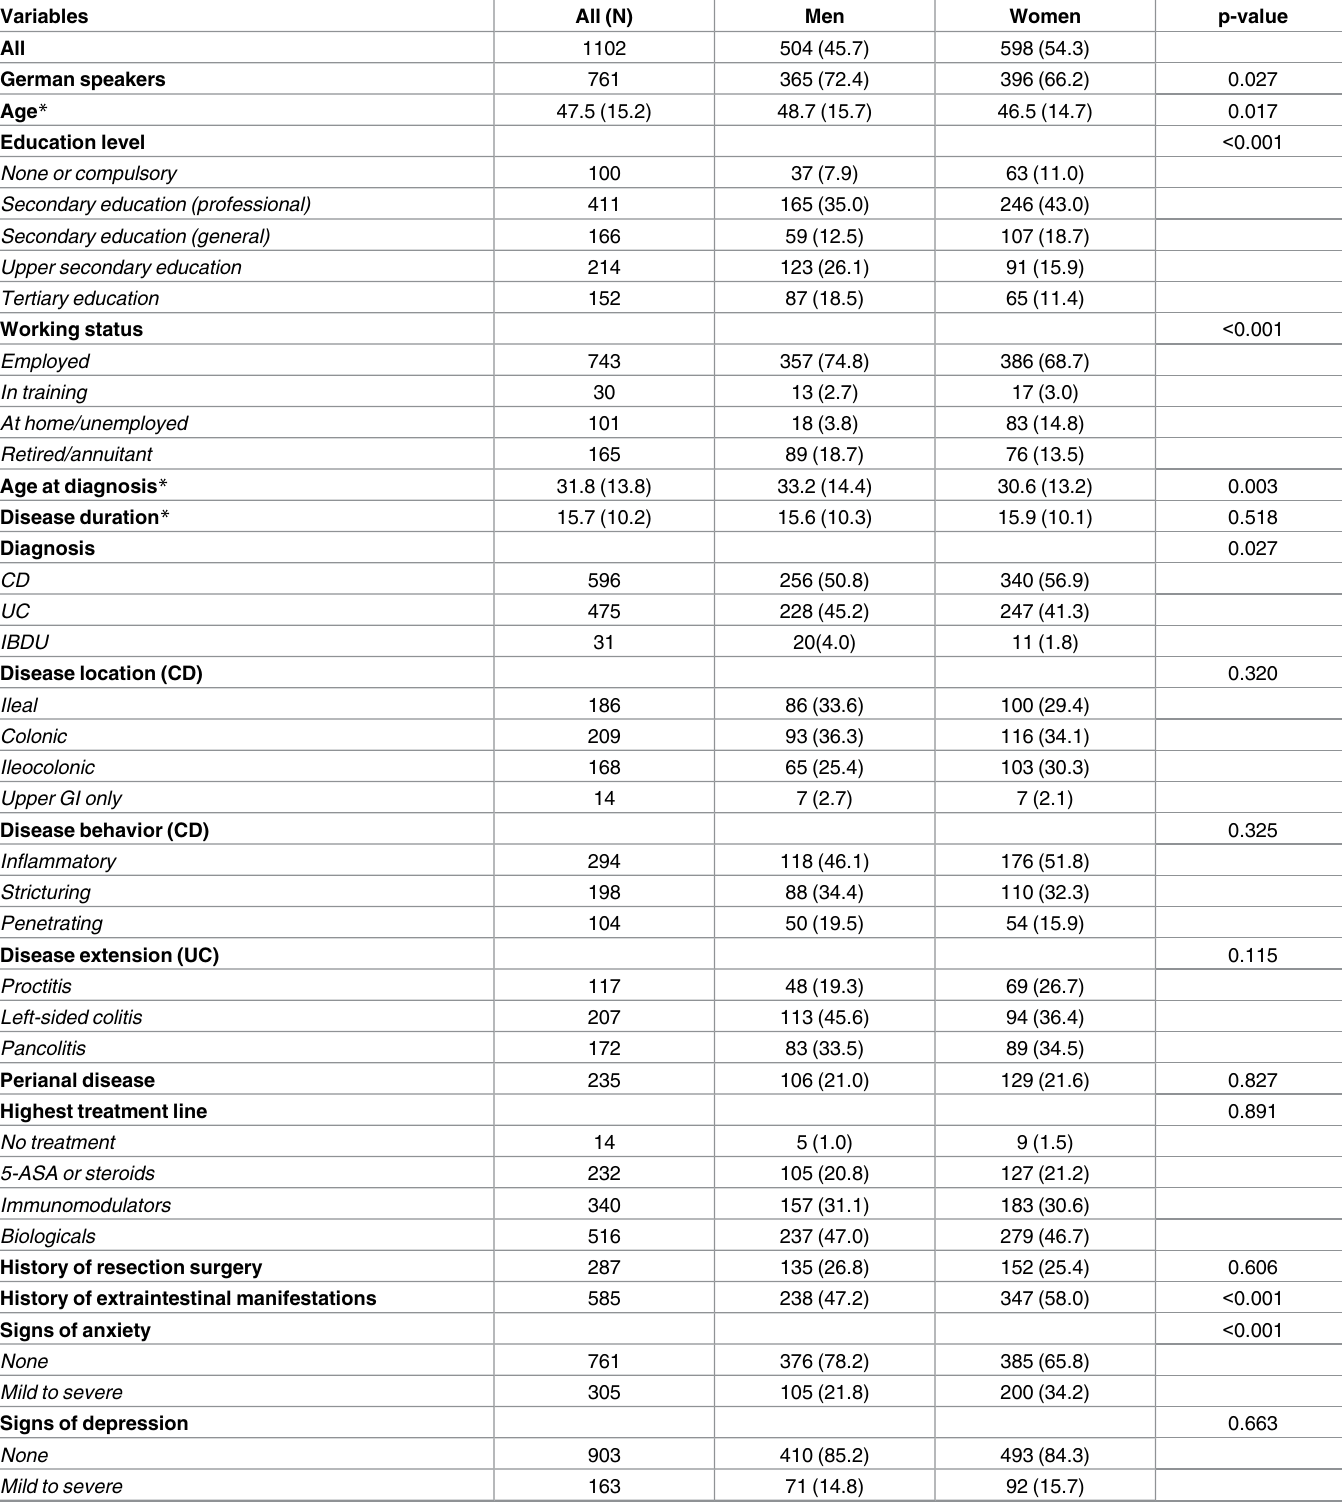
Table 1. Baseline patient characteristics. Values are numberand percentagesunless